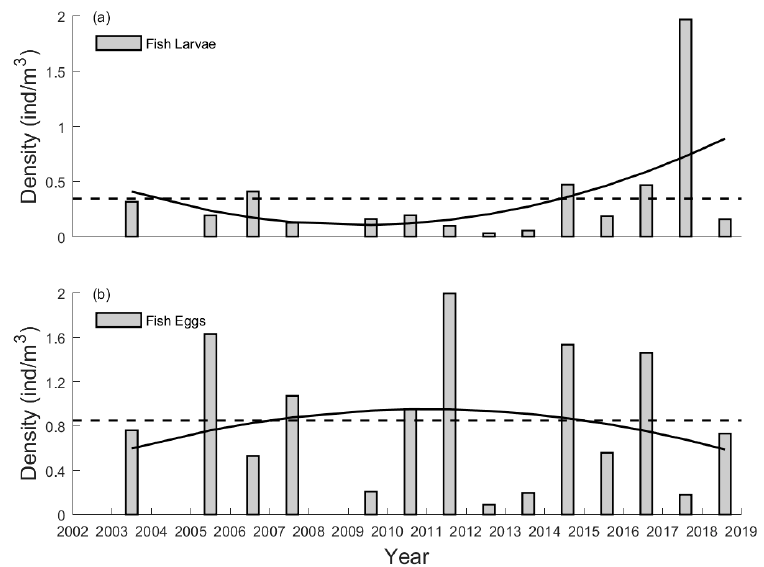
Figure 2. Summer abundance (in density) of fish larvae and eggs in the PRE from 2003 to 2018. The dashed line represents the multi-year mean value and the solid line is the regression based on a quadratic function. ( a ) Fish Larvae ( b ) Fish Eggs.